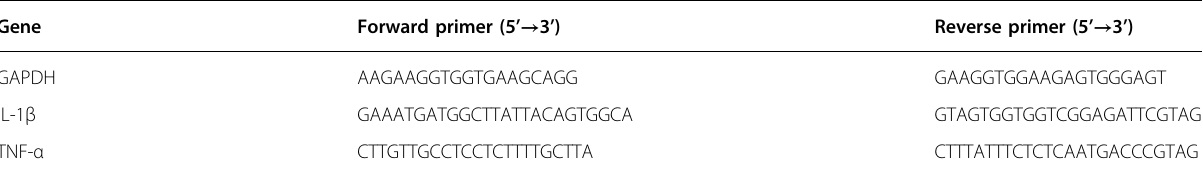
Table 1 QRT-PCR primers used in this study.